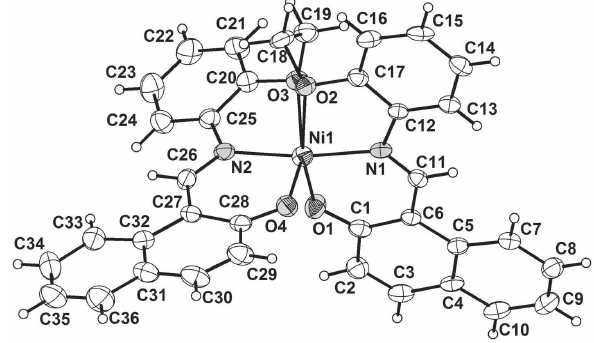
Table 1: Data collection and